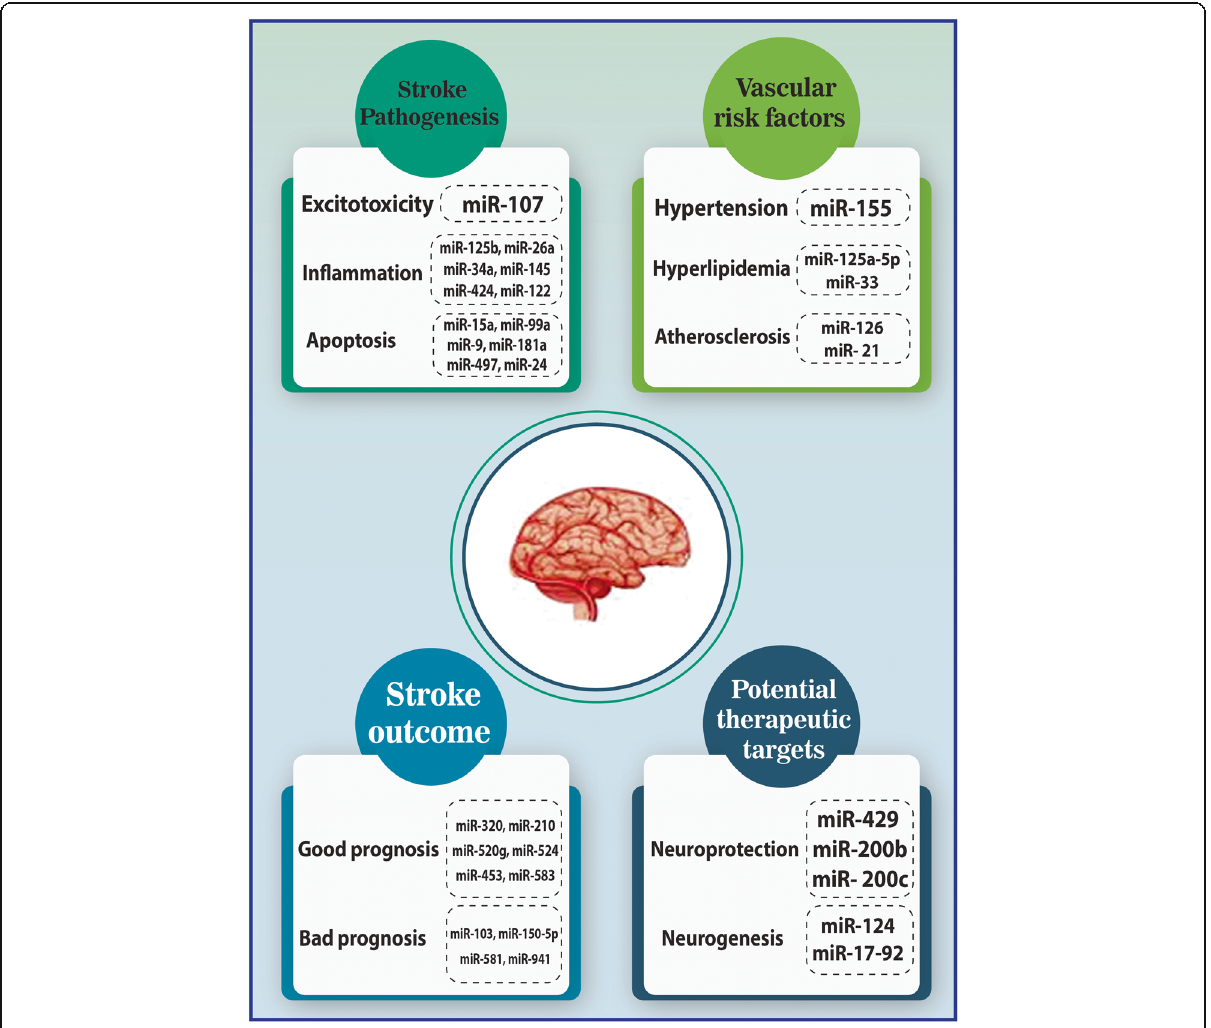
Fig. 3 Micro RNAs dysregulation in ischemic stroke. Multiple microRNAs in pathogenic mechanisms (excitotoxicity, inflammation, and apoptosis), risk factors, and stroke outcome. Some are promising therapeutic targets (neurogenesis and